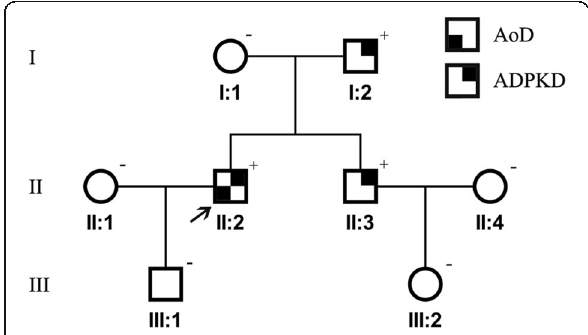
Fig. 1 Pedigree; Proband is indicated with an arrow. Plus and minus sign indicate presence or absence of a PKD2 mutation, respectively. AoD: aortic dissection; ADPKD: autosomal dominant polycystic kidney